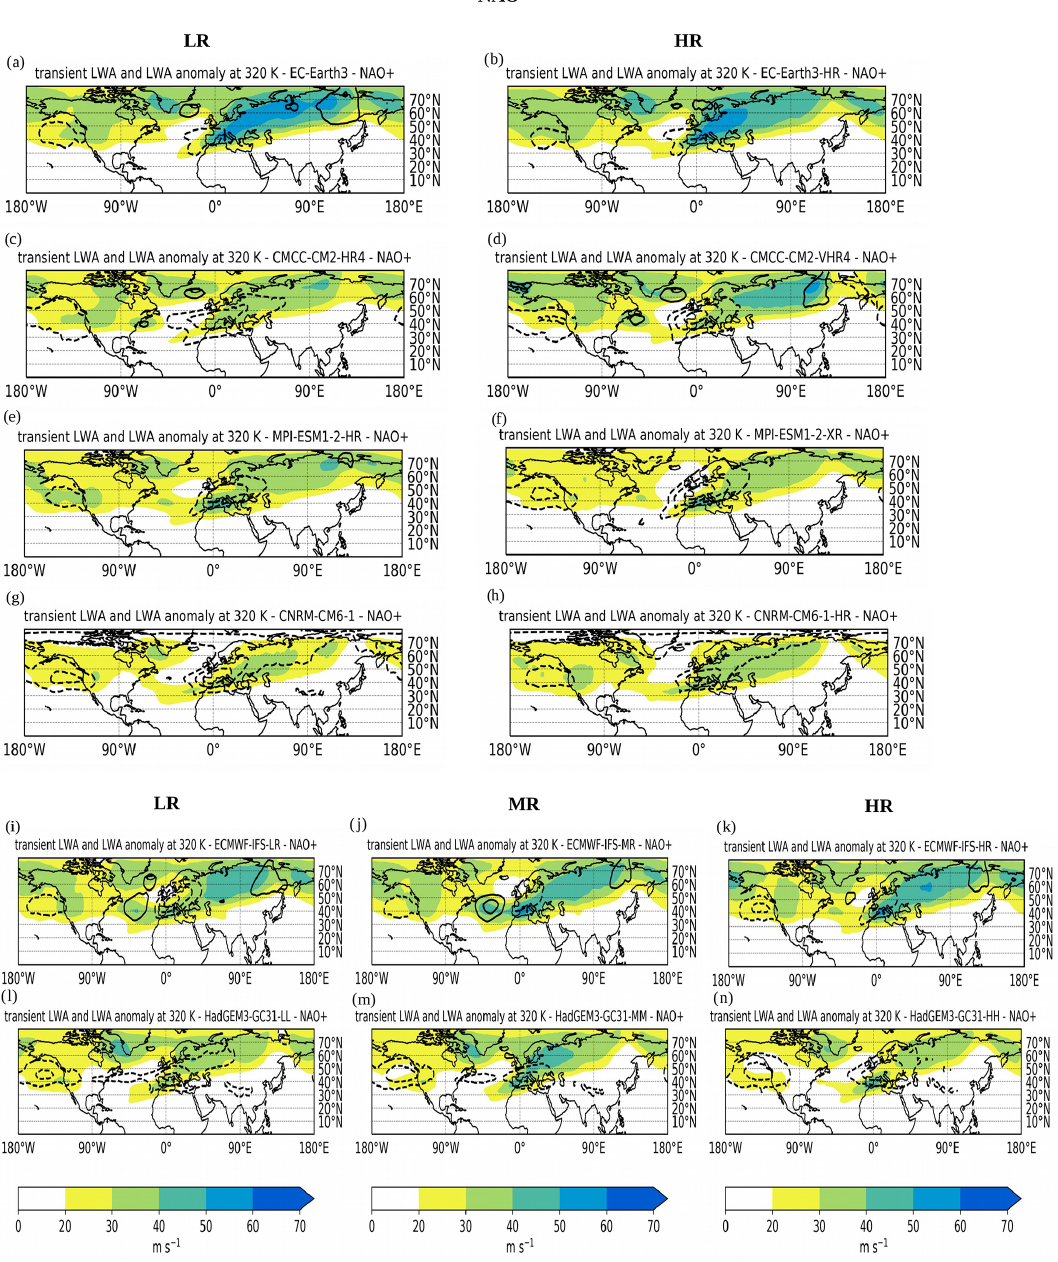
Figure 8. Transient LWA (colour, units ms − 1 ) and transient LWA anomalies with respect to ERA5 (black contours every 10ms − 1 ; dashed contours represent negative values) at 320K associated with NAO+ for